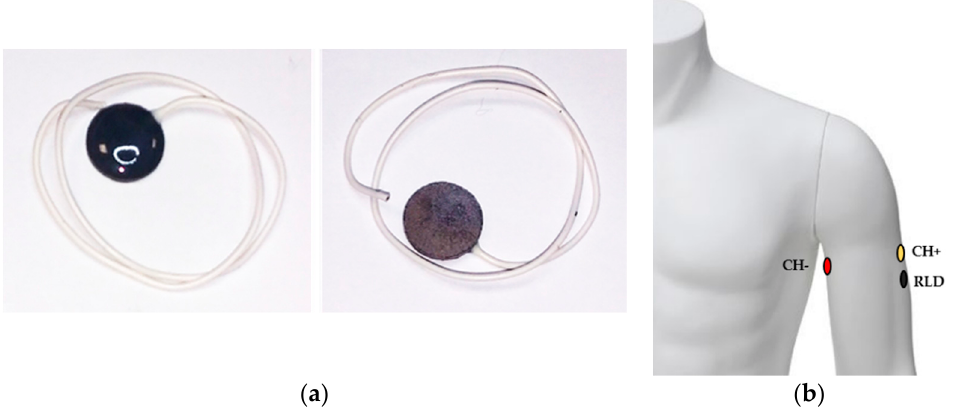
Figure 2. Arm-ECG sensor: ( a ) top and bottom views of the sintered Ag–AgCl electrodes disks used in the system; ( b ) electrode positions on the left upper-arm.